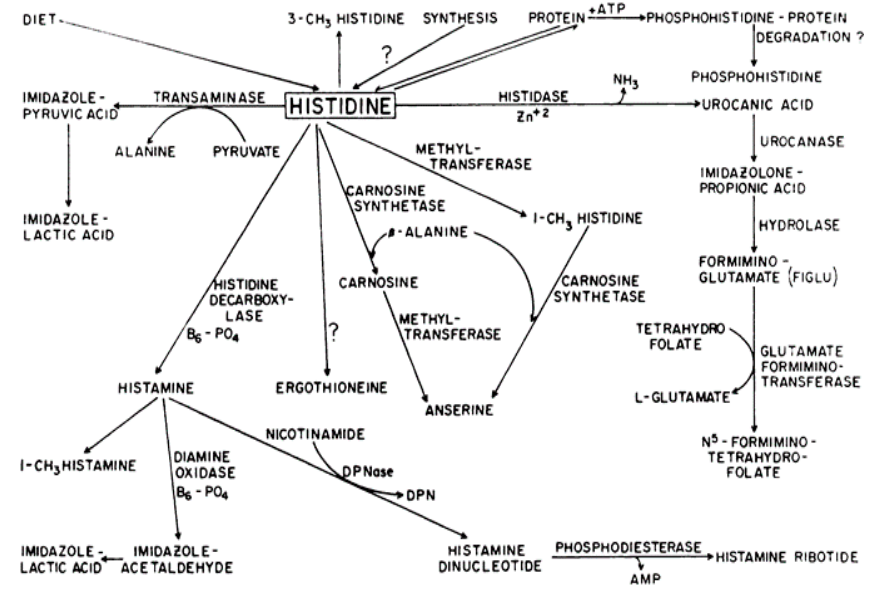
Figure 1. Catabolic pathways of histidine [11].